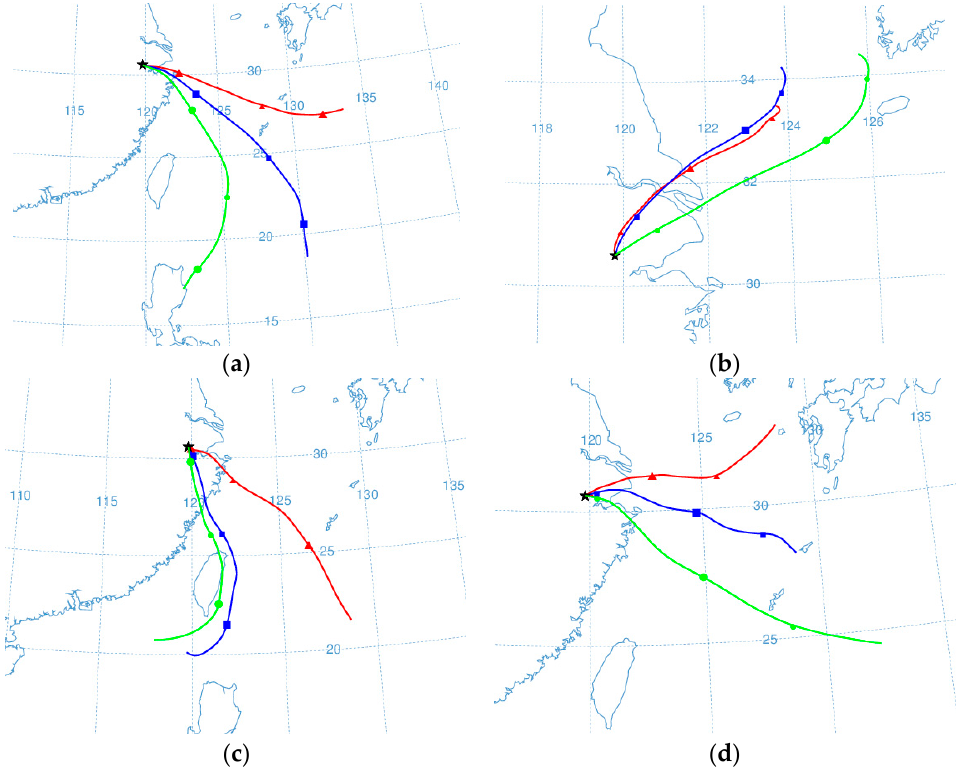
Figure 6. Moisture transport pathways to Hemuqiao basin for four typhoon events. The three colorful lines in the air trajectory figure represent three different pathways of moisture sources. Figure ( a – d ) represents Event 1, 2, 3 and 4,